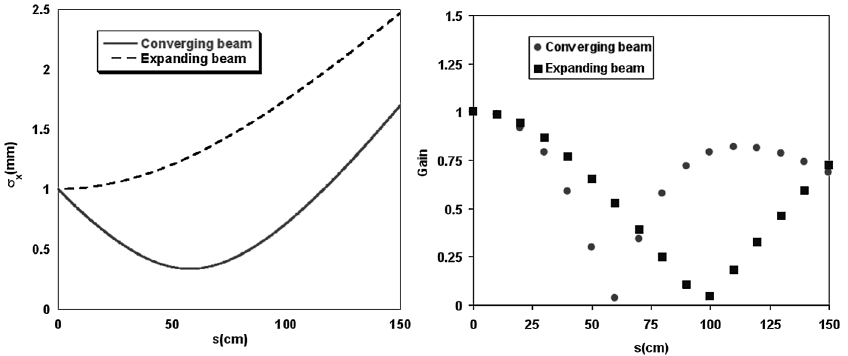
FIG. 6. Left: evolution of the transverse rms beam size (cid:8) corresponding linear gains for an initial modulation of wavelength (cid:5) ¼ 100 (cid:12) m